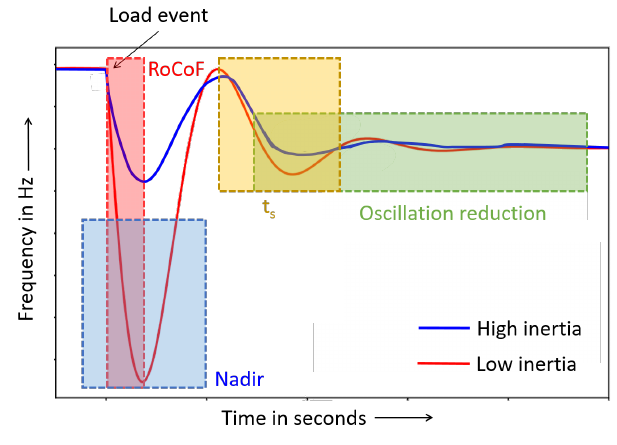
Figure 6. Frequency response